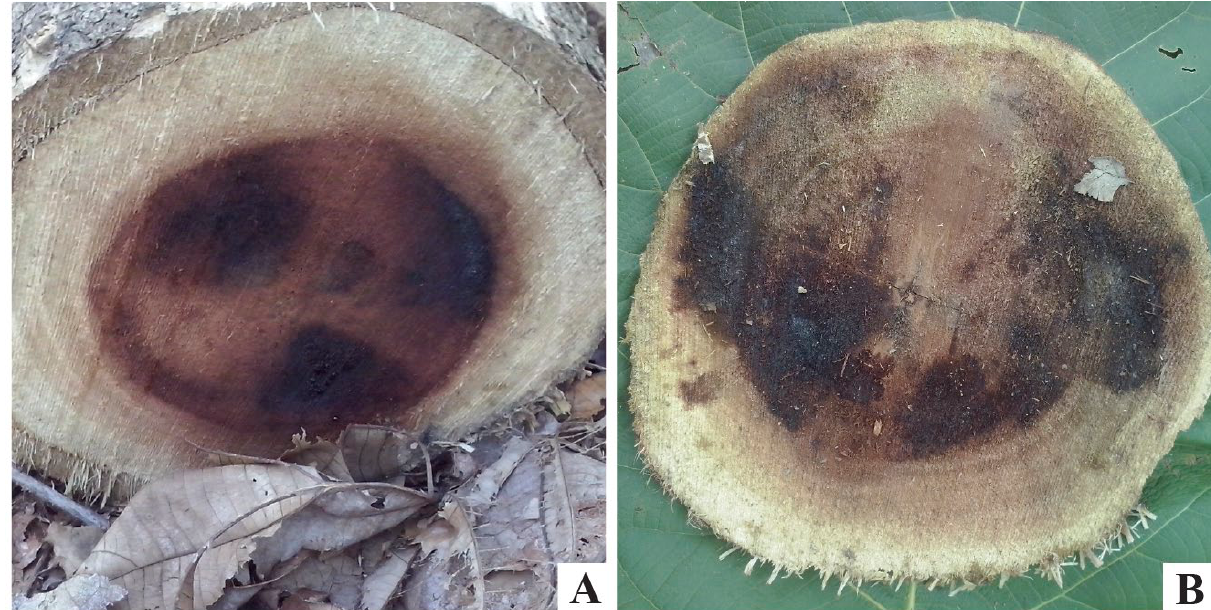
Figure 1. Cross sections of teak ( Tectona grandis ) tree trunks displaying heartwood and sapwood (xylem) darkening as well as black vascular areas (a and